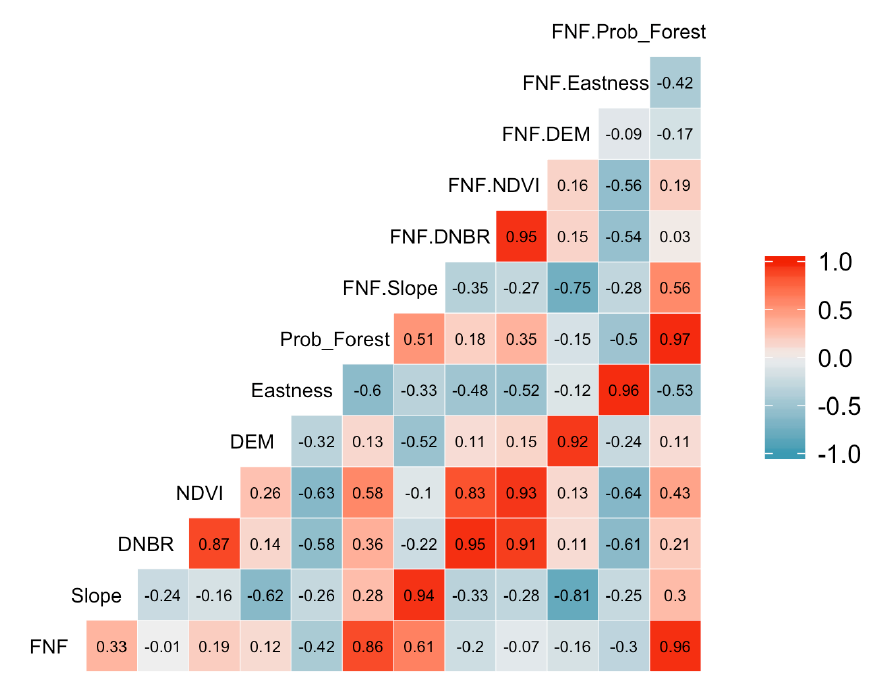
Figure 4. Correlation matrix of the potential predictors, including the interaction terms. High correlation exists between the predictors and their interaction term with FNF and between DNBR and NDVI.